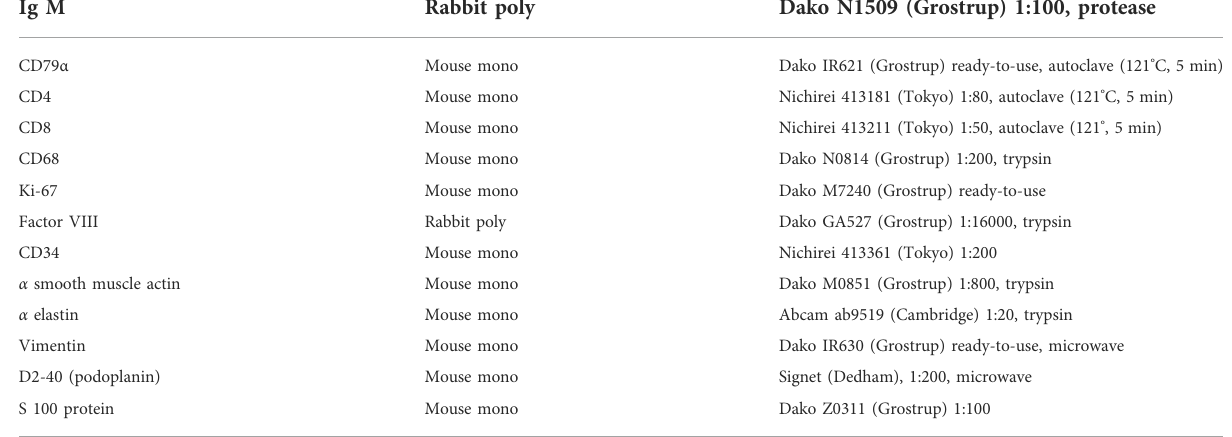
TABLE 1 Primary antibodies and their dilution and speci fi c